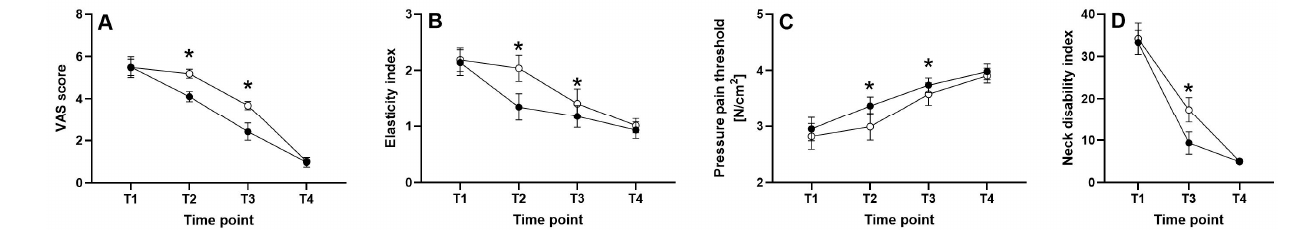
Figure 3. ( A ) Mean and standard deviation of the VAS score of the patients in the Lidocaine arm (closed dots) and the patients in the rESWT arm (open dots). ( B ) Mean and standard deviation of the elasticity index of the patients in the Lidocaine arm (closed dots) and the patients in the rESWT arm (open dots). ( C ) Mean and standard deviation of the pressure pain threshold of the patients in the Lidocaine arm (closed dots) and the patients in the rESWT arm (open dots). ( D ) Mean and standard deviation of the neck disability index of the patients in the Lidocaine arm (closed dots) and the patients in the rESWT arm (open dots). In all panels the asterisks indicate statistically significant differences ( p < 0.05) between the arms (c.f. Table 2). Abbreviations: T1, baseline; T2, immediately after the first treatment; T3, before the second treatment (i.e., one week after baseline); T4, one week after the third treatment (i.e., four weeks after baseline).